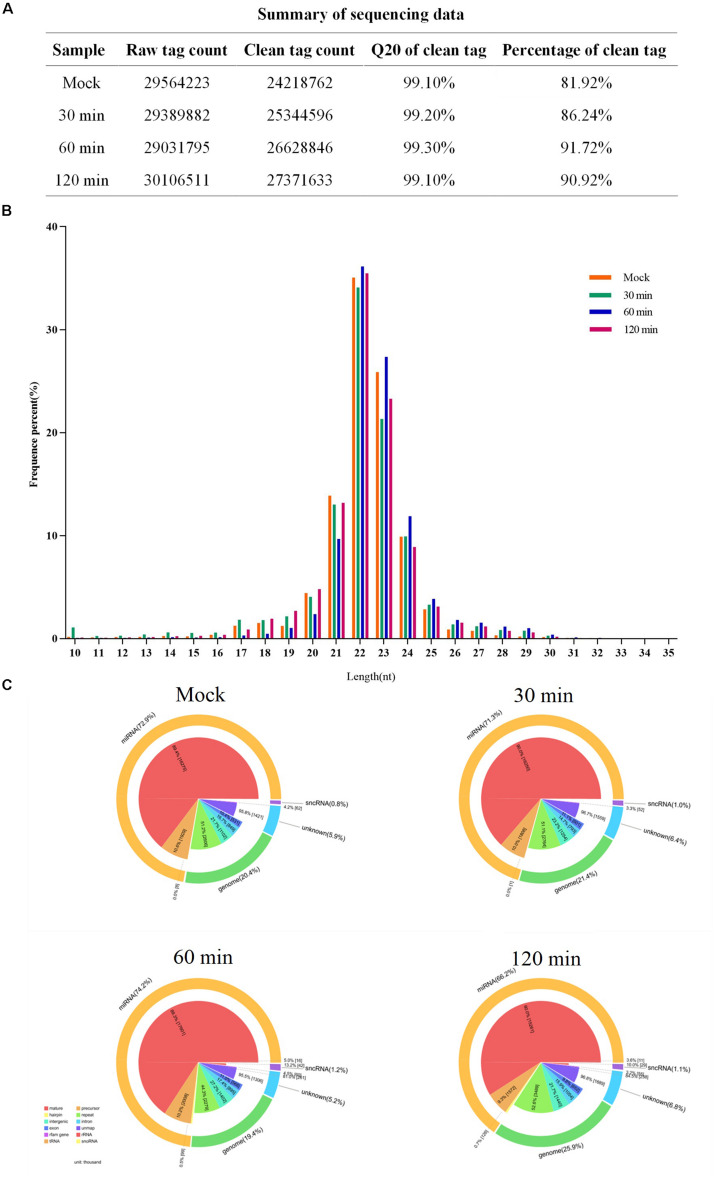
Summary of sequencing data for each sample. (A) The sequencing data for each sample. (B) Size distribution of sequenced miRNA-seq reads. The majority of miRNAs in FAdV-4-infected and mock LMH cells measure 21–23 nt in length. (C) Pie charts of miRNA-seq showing the percentage of miRNA components in FAdV-4-infected and mock LMH cells.